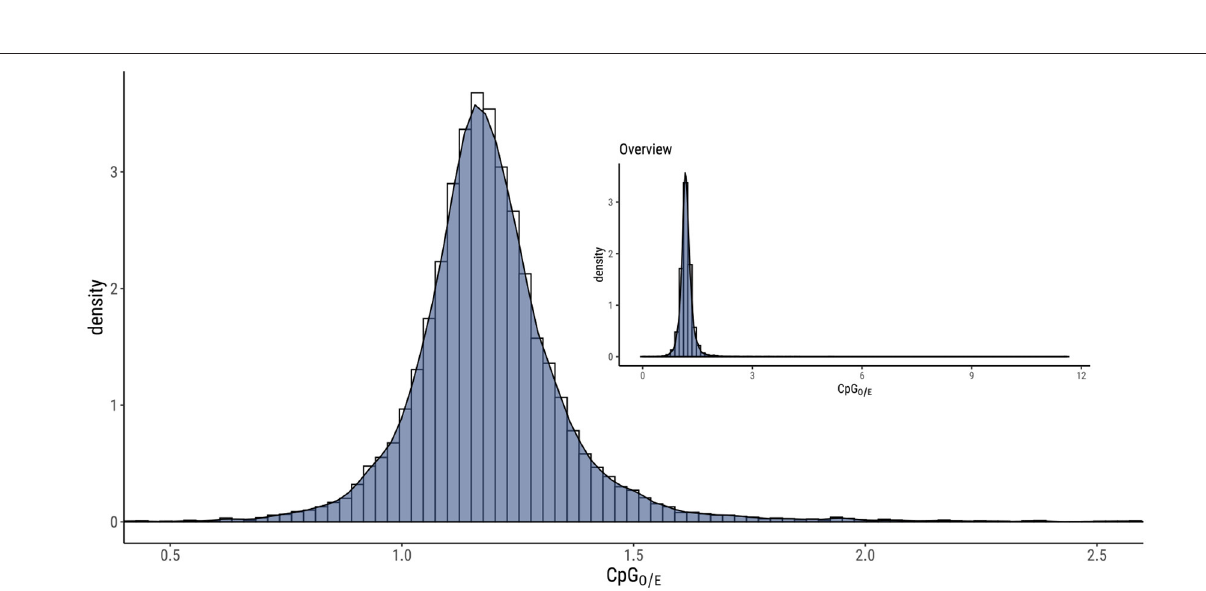
upregulated (24 %) or downregulated (26 %) in larvae compared to imagoes ( Supplementary Table 5 ). Gene ontology enrichment analysis revealed eight functional categories with